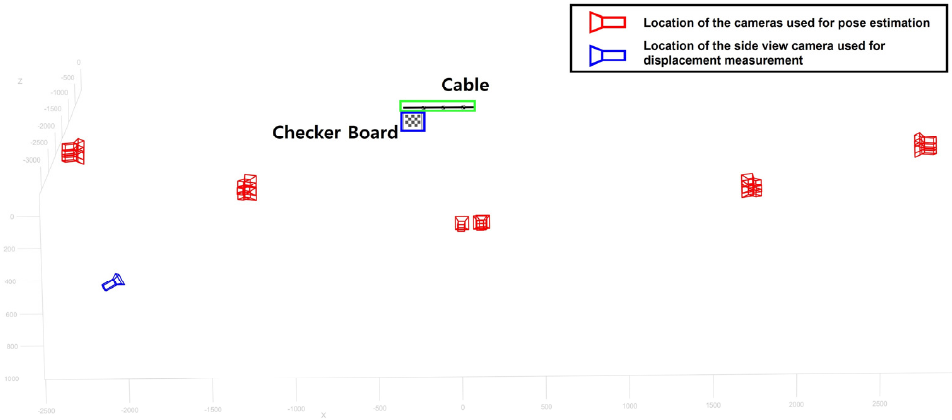
Figure 7. Camera pose estimation result for the simulation validation test.